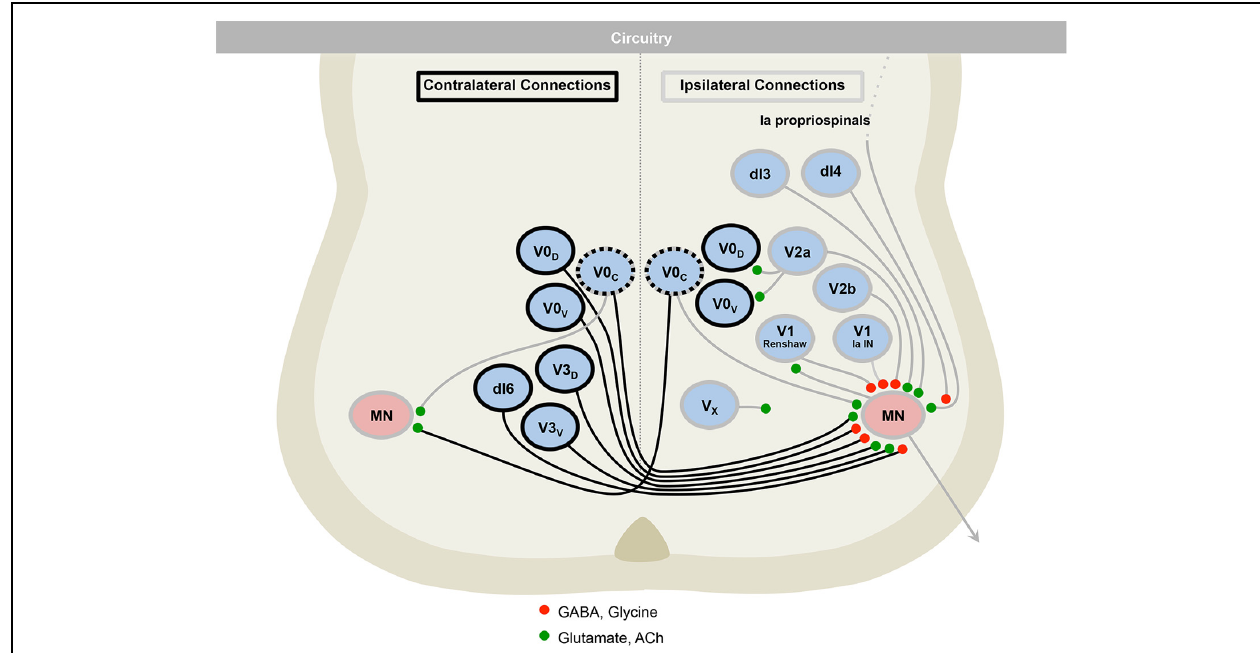
FIGURE 5 | The motor circuitry is shown in diagrammatic form in the lower panel. Here, neurons can be divided by projection patterns, that are ipsilateral, contralateral, or both. Three classes of neurotransmitter are found in the cord: excitatory glutamatergic (e.g.,